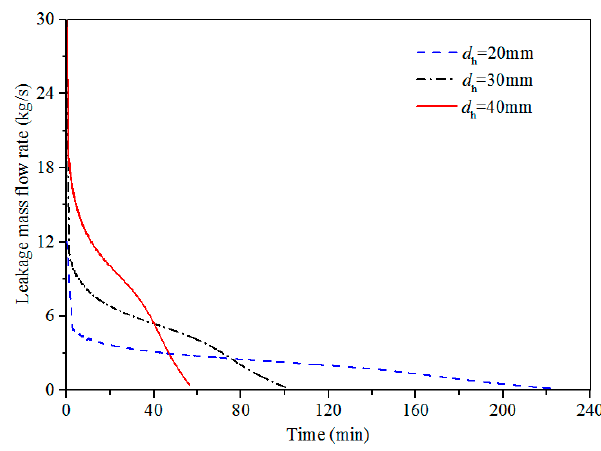
Figure 19. The leakage mass flow rate curves with different leak hole diameters.